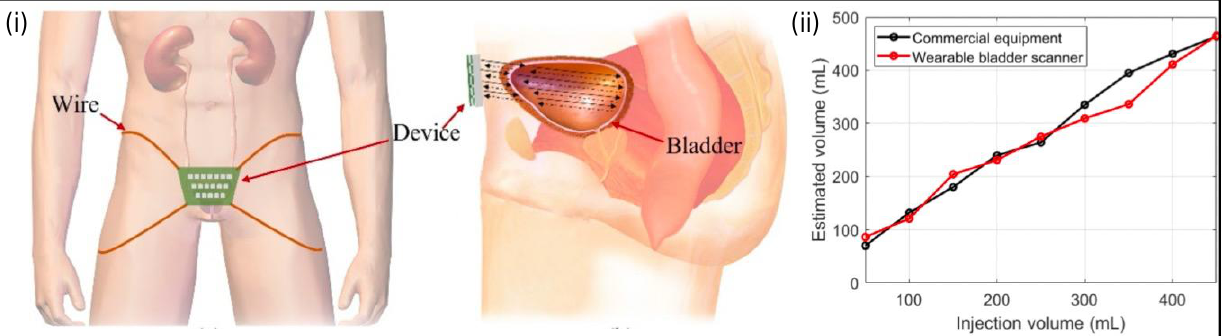
Figure 5. The proposed wearable bladder scanner system. ( i ) The front and side view of the device; ( ii ) estimated bladder volume measured by the proposed device and commercial equipment for various injection volumes [89].